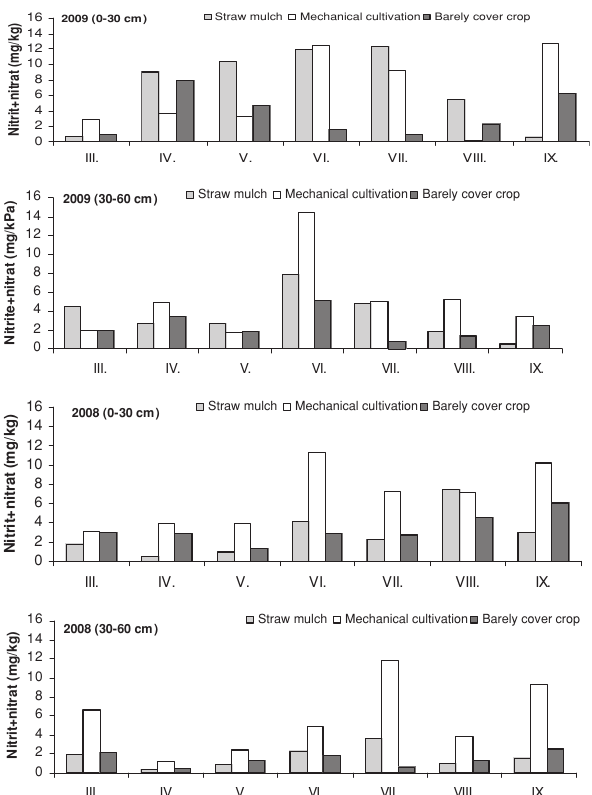
Figure2. The nitrite and nitrate content of the soil in the 0–30 cm and 30–60 cm depth, from March to September (Tokaj, 2008–2009)